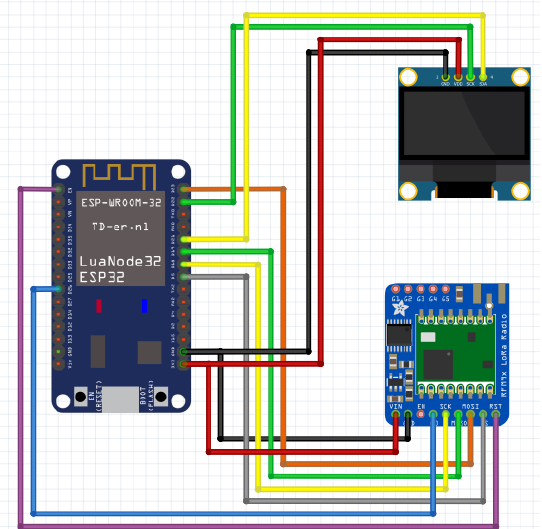
Figure 3. Scheme of ESP32 device connected to RFM95 module that implements LoRa communication.